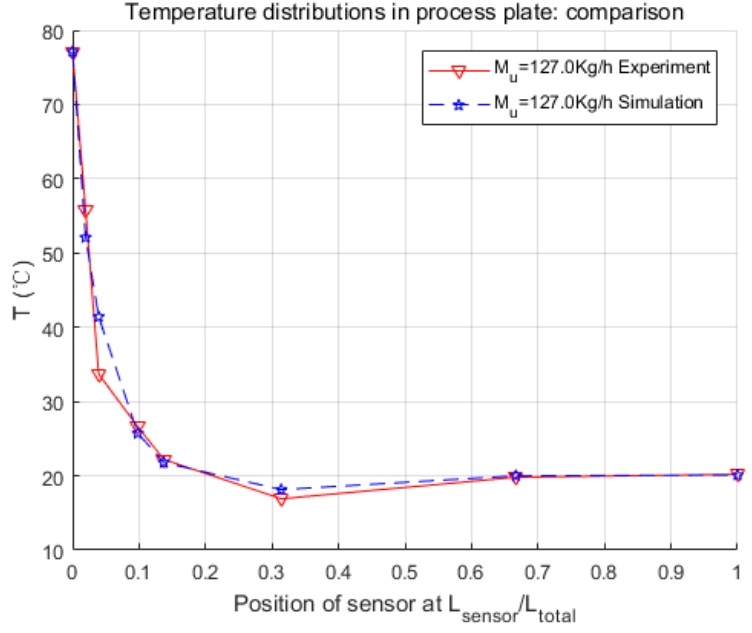
. M p = 10 kg · h − 1 and